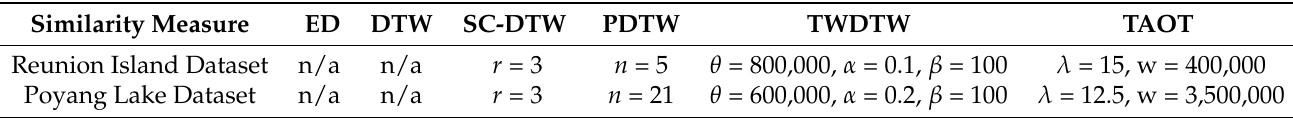
Table 7. Optimal parameters for each method on the two